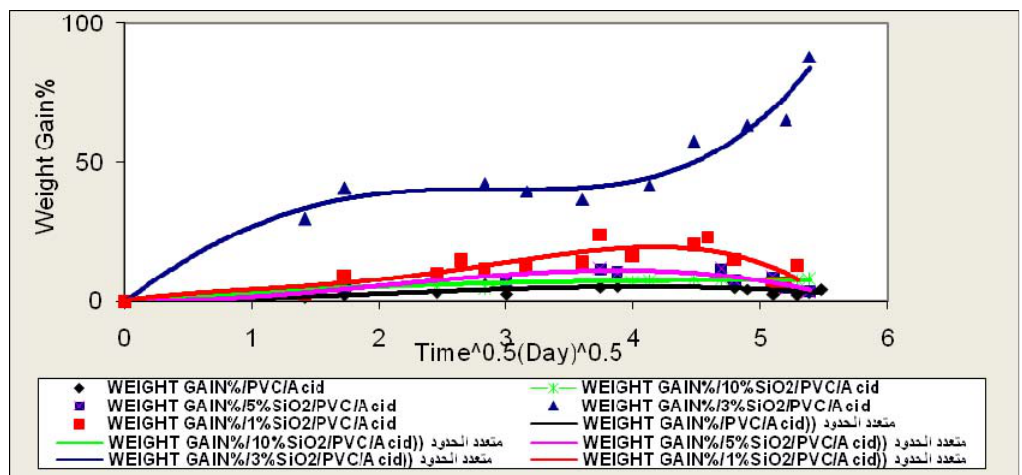
Fig. 6: Weight gain (%) of PVC & SiO